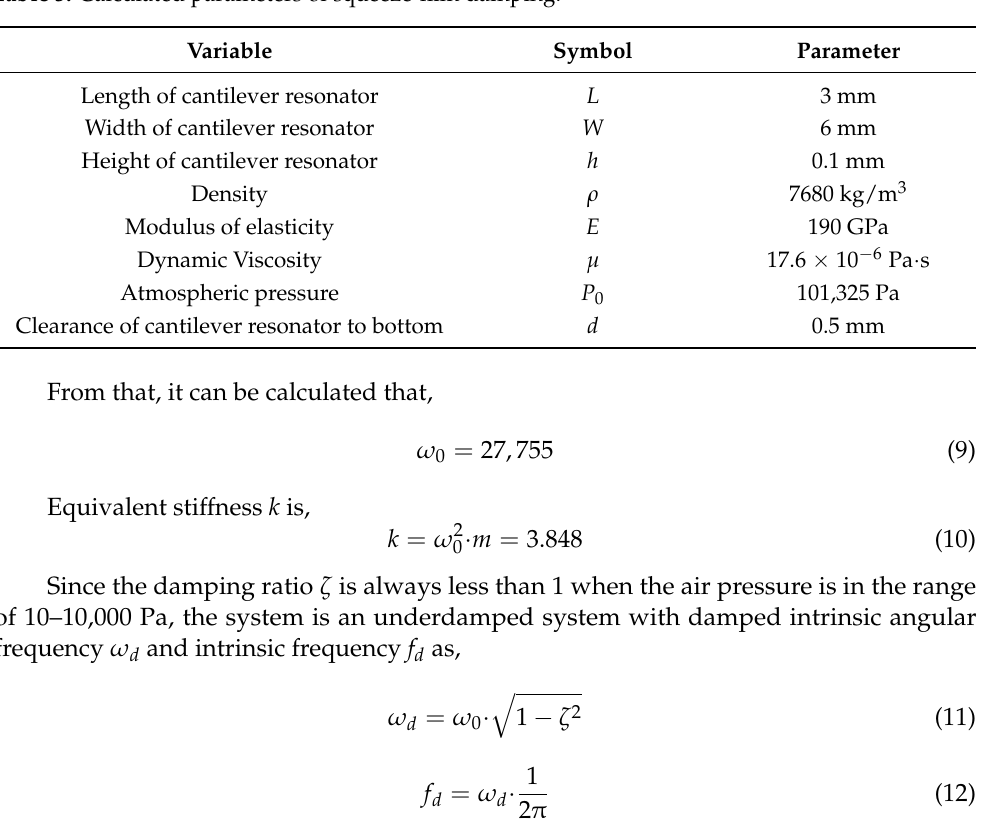
Table 3. Calculated parameters of squeeze-film damping.